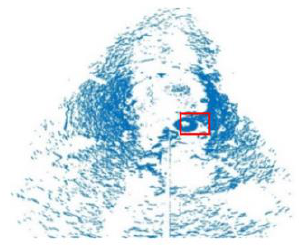
Figure 8. 2D bird’s eye view of the point cloud.